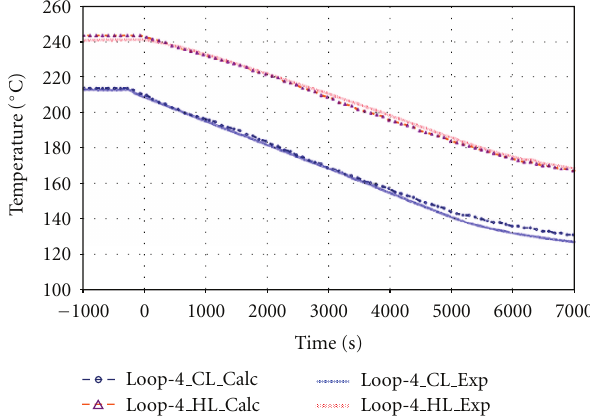
Figure 14: Run-2: Secondary side pressure evolution in the active